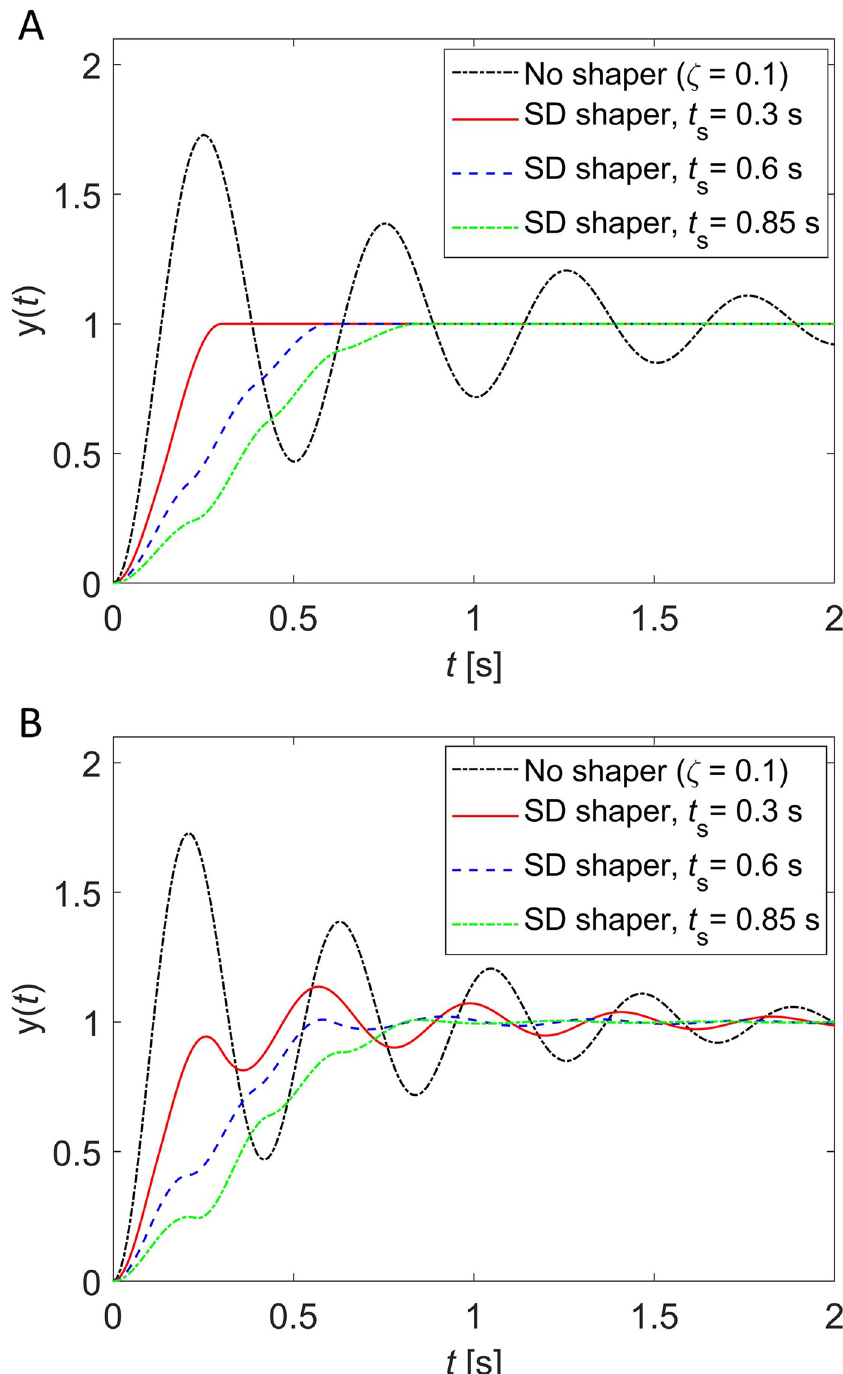
Fig 7. Unit-step responses when SD shapers with shaping time t s = 0.3, 0.6, 0.85s are used for an underdamped system ω 2 = ð s 2 þ 2 ζω Þ with ^ ω ¼ 2 Hz and ζ = 0.1. (A) No modeling error ( o s þ ω 2 n n n n modeling error in natural frequency ( ω n = 2.4 Hz, ^ o ¼ 2 Hz n